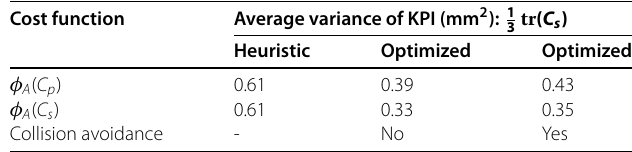
Table 8 Key performance indicator (KPI) average variances (mm 2 ) of 90 experiments with heuristic and optimized experimental design for parameter